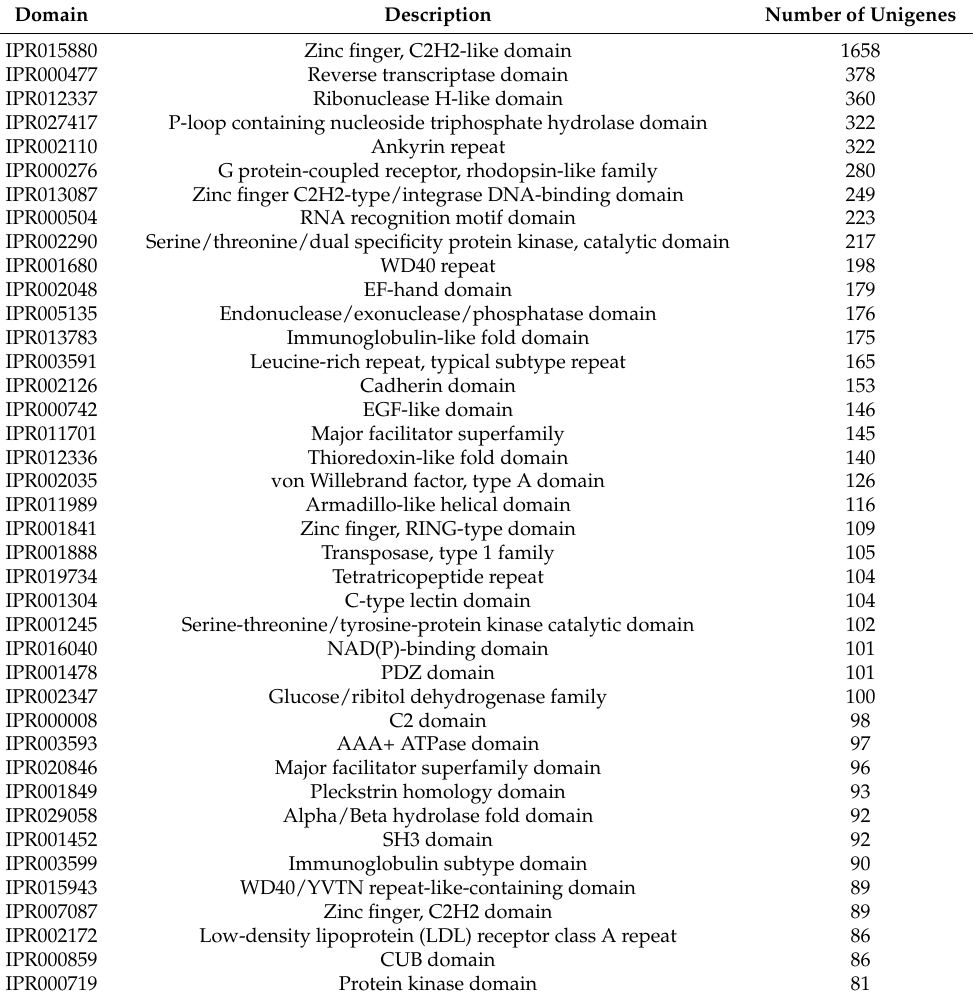
Table 4. Top hit InterPro terms from the InterProScan annotations of A. quelpartensis